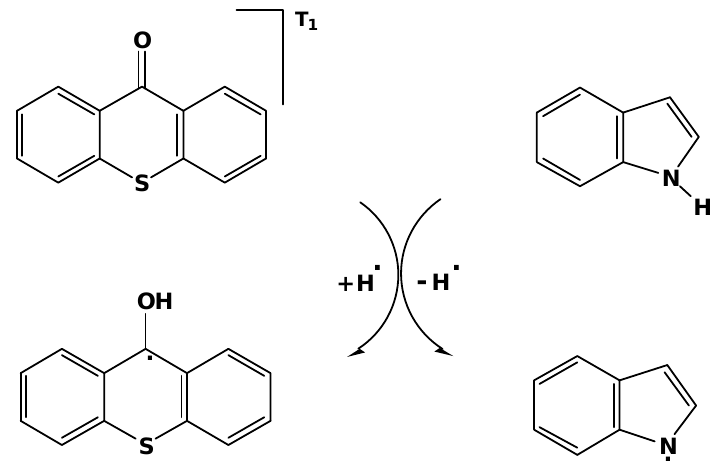
Scheme 1. Proposed H-atom transfer-based deactivating pathway of triplet excited state thioxanthone by